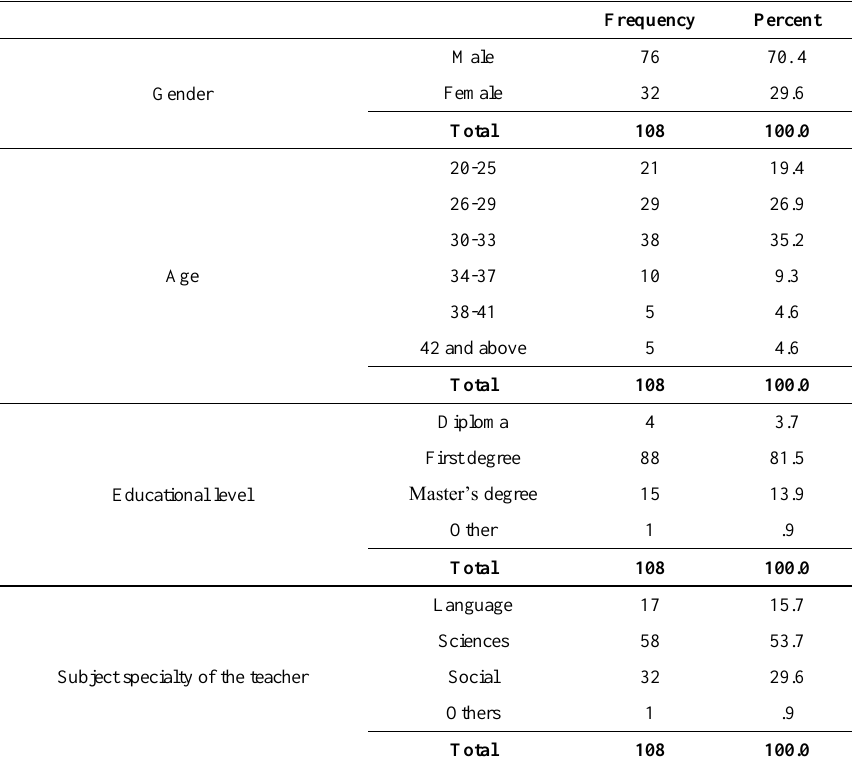
Table 3. Teachers as study participants (number of schools